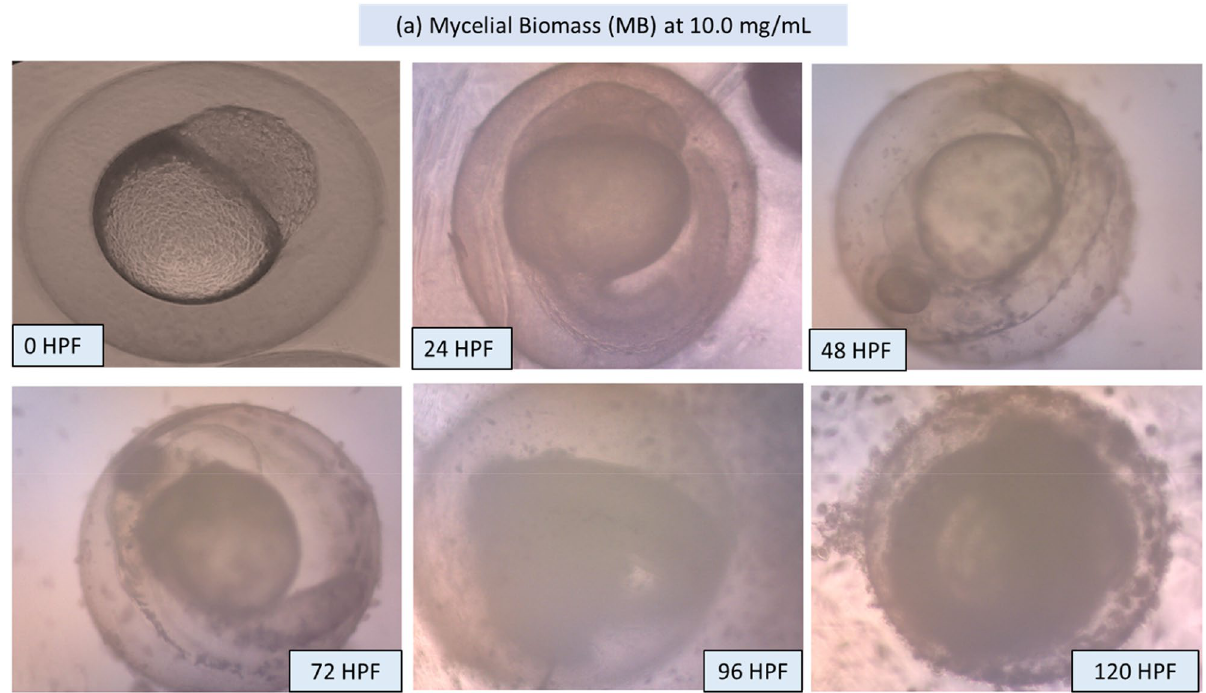
Figure 8. Illustrations of zebrafish embryo and larvae development after treated with Tiger Milk mushroom Lignosus rhinocerus strain ABI at high EPS concentration of 10.0 mg/mL. Descriptions were captured using